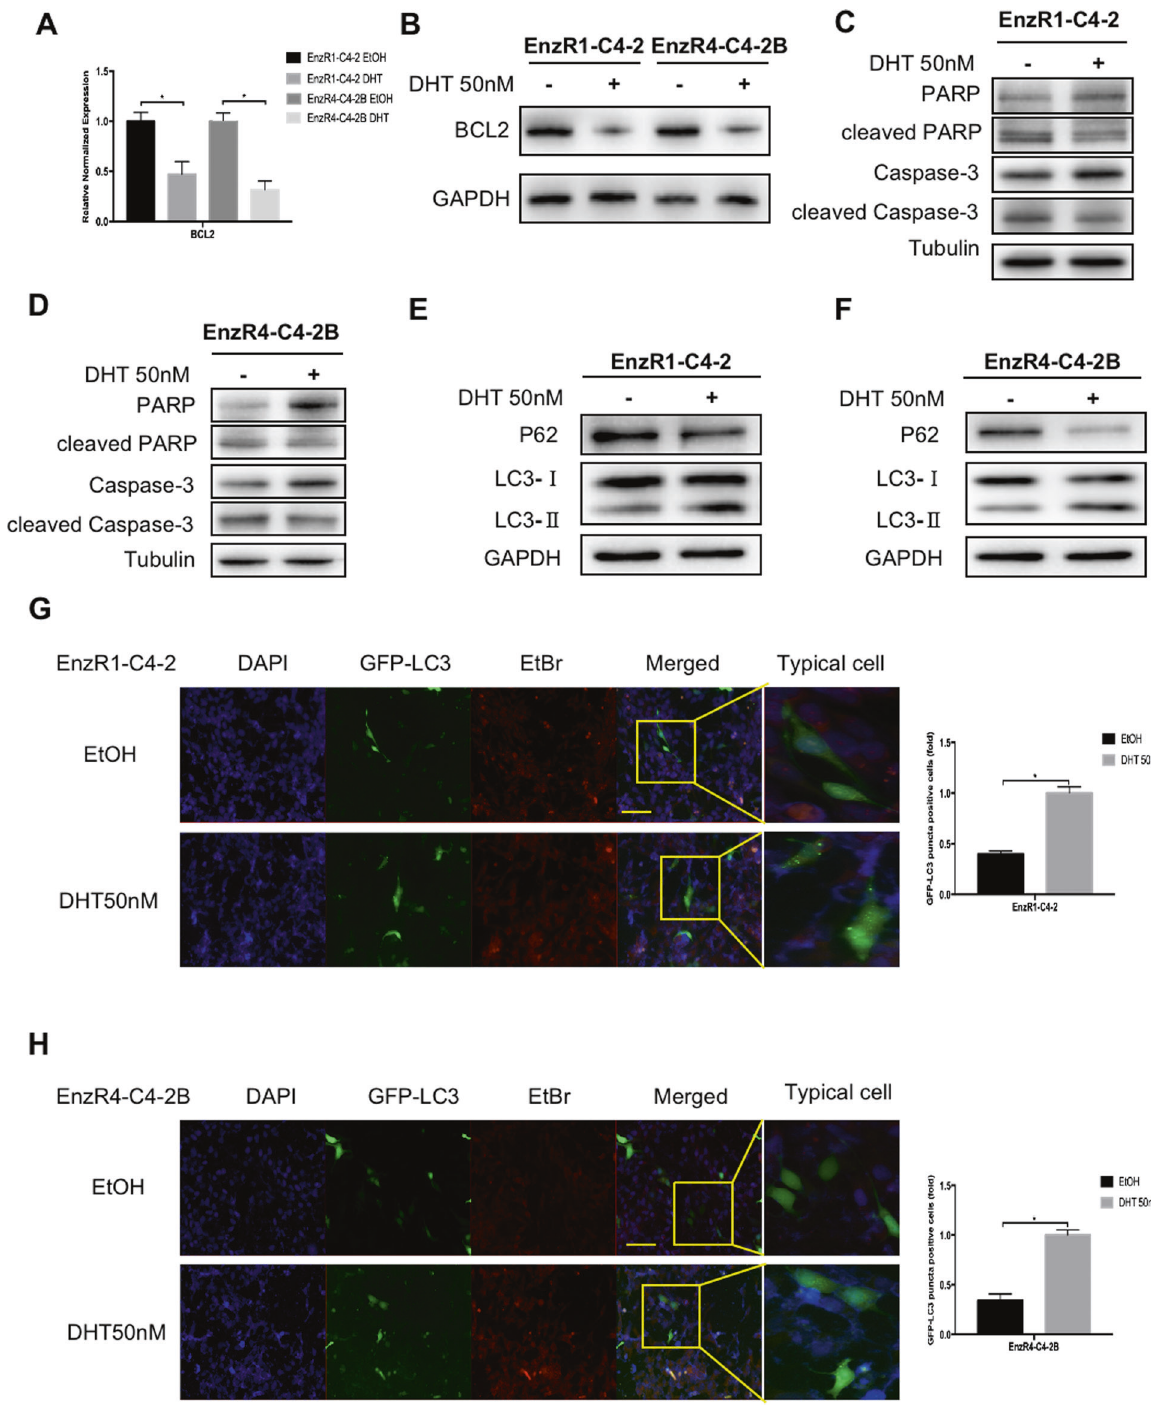
Fig. 2 High-dose-DHT suppresses EnzR PCa cell growth via induction of autophagic cell death. A BCL2 mRNA expression in EnzR1-C4-2 and EnzR4-C4-2B cell lines treated with/without (w/wo) 50 nM DHT. B BCL2 protein expression in EnzR1-C4-2 and EnzR4-C4-2B cell lines treated w/ wo 50 nM DHT. C , D Western blot assays were performed on EnzR1-C4-2 ( C ) and EnzR4-C4-2B ( D ) cell lines to show that caspase-dependent apoptosis marker is decreased with 50 nM DHT treatment. E , F Western Blot was performed on EnzR1-C4-2 and EnzR4-C4-2B cell lines to show that autophagy markers LC3 (LC3-I and LC3-II) are increased ( E ) and p62 is decreased ( F ) with 50 nM DHT treatment. G , H GFP-LC3 plasmid transfection was performed using Lipofectamine 3000 transfection reagent on EnzR1-C4-2 ( G ) and EnzR4-C4-2B ( H ) cells to show that GFP-LC3 puncta positive cells increased with 50 nM DHT treatment. The fl uorescence images were captured by microscopy, scale bar = 40 µm. Data are presented as means ± SD. * p < 0.05.